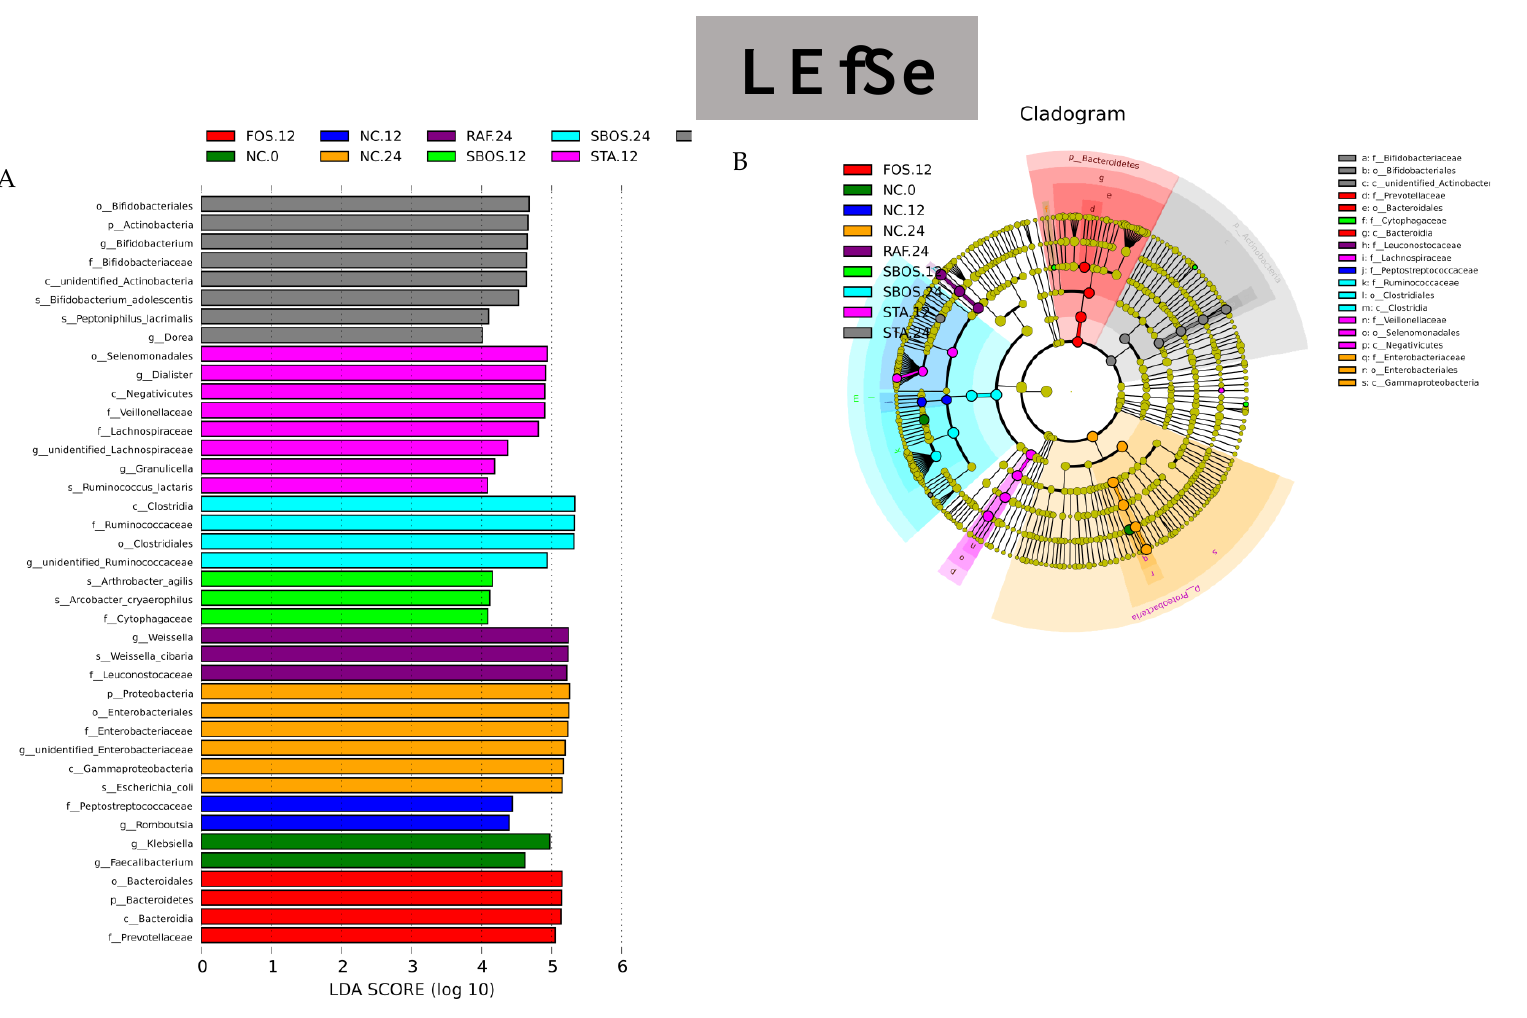
Figure 8. Distribution histogram ( A ) based on linear discriminant analysis (LDA): LDA score threshold >4.0 and cladogram ( B ) representation of taxa using linear discriminant analysis effect size (LEfSe).